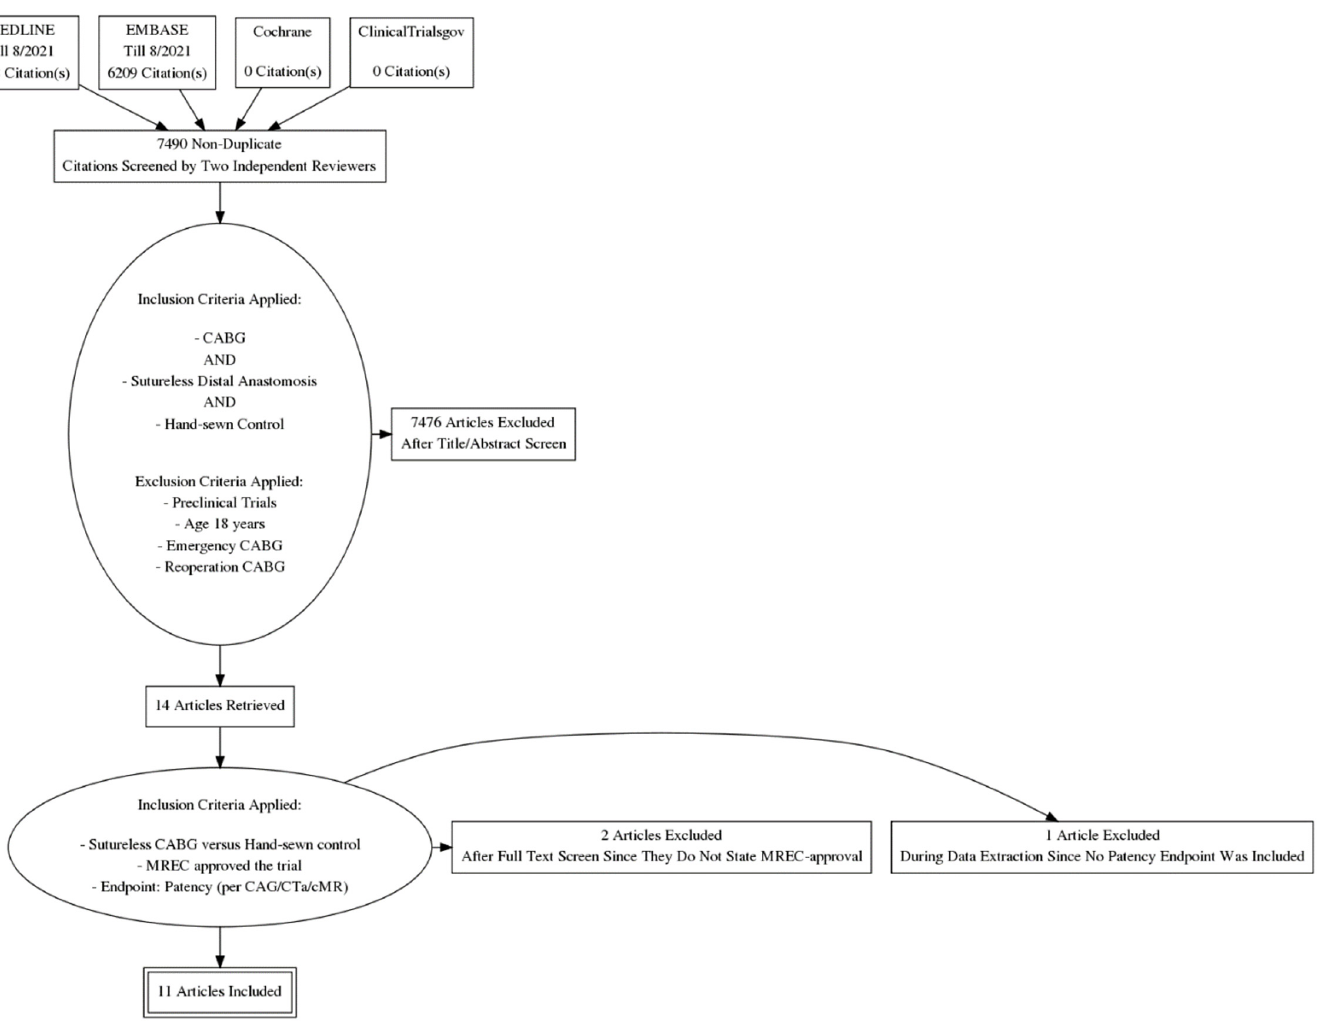
Figure 1. PRISMA flow-chart of systematic review search outcomes. CABG: coronary artery bypass grafting; CAG, coronary angiography; MREC: medical research ethics committee; CTa: computed tomography angiography; cMR: cardiac magnetic resonance imaging.